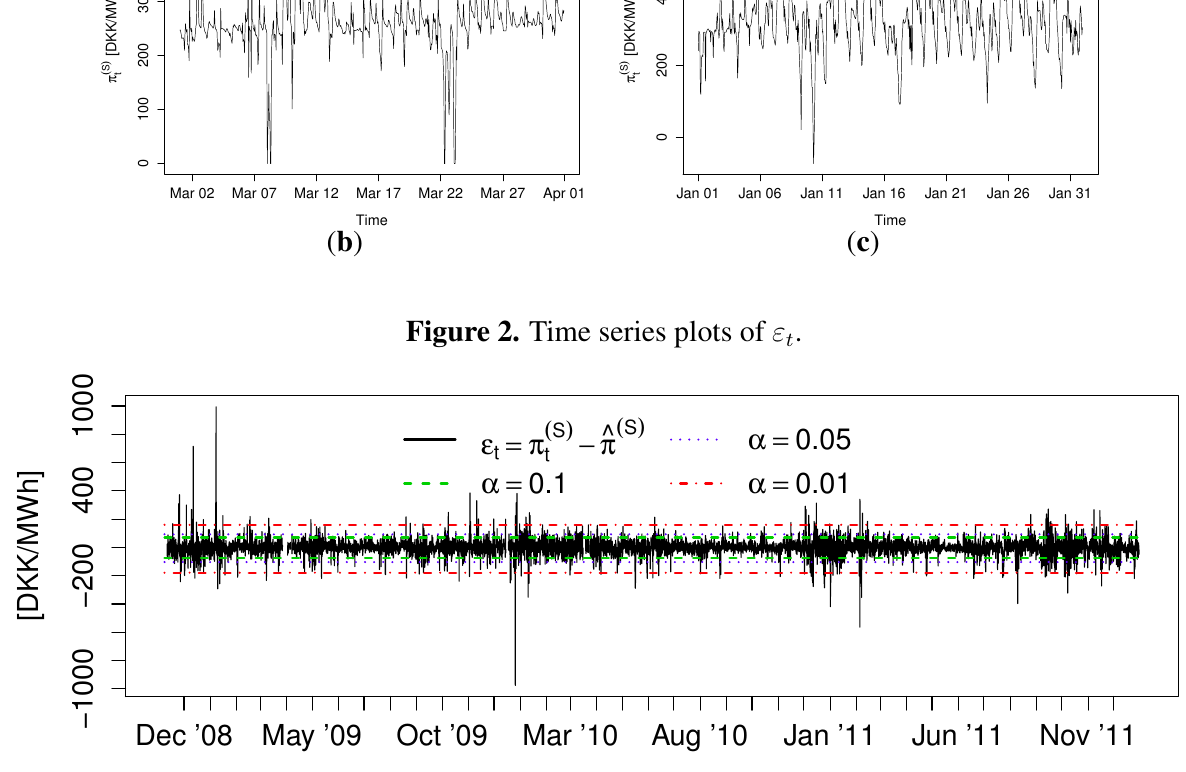
Figure 2. Time series plots of ε